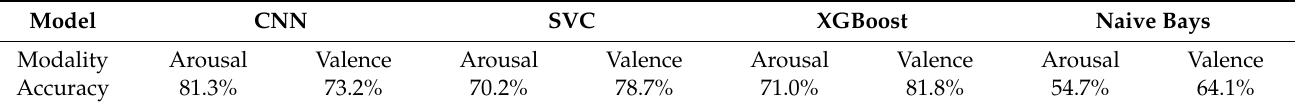
Table 2. Classification accuracy of each model.